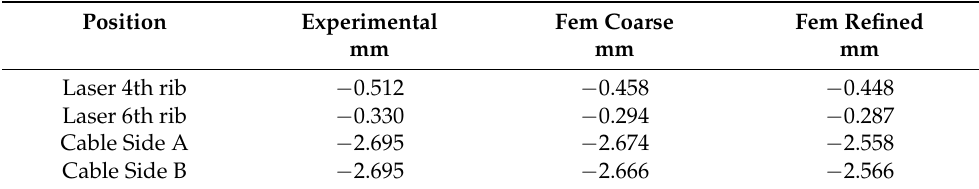
Table 7. Comparisons between the numerical displacements (coarse and refined) and the experiments for the wind load